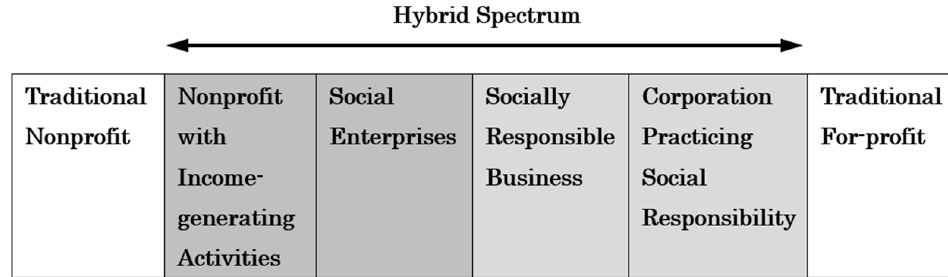
Figure 2. Social entrepreneurs’ process of choosing institutional logics. Source: Author.